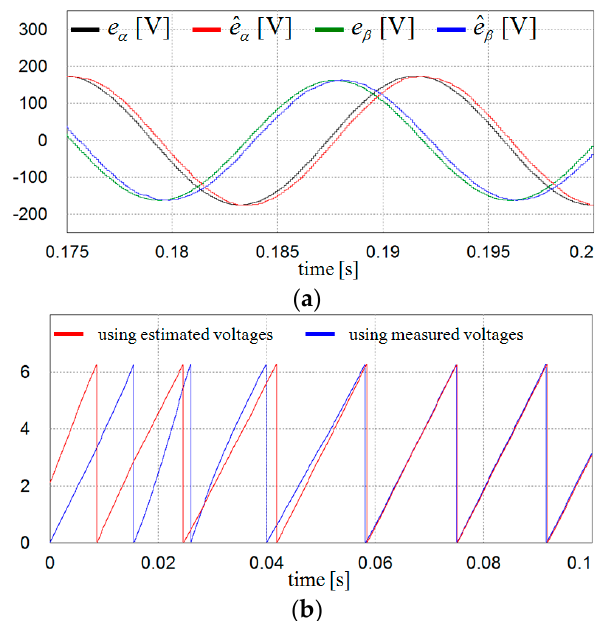
Figure 7. Estimation of grid voltages and phase angle using DOB under unbalanced grid condition. ( a ) Measured and estimated stationary q -axis and d -axis grid voltages; and ( b ) PLL results using measured voltages and estimated voltages at start-up.